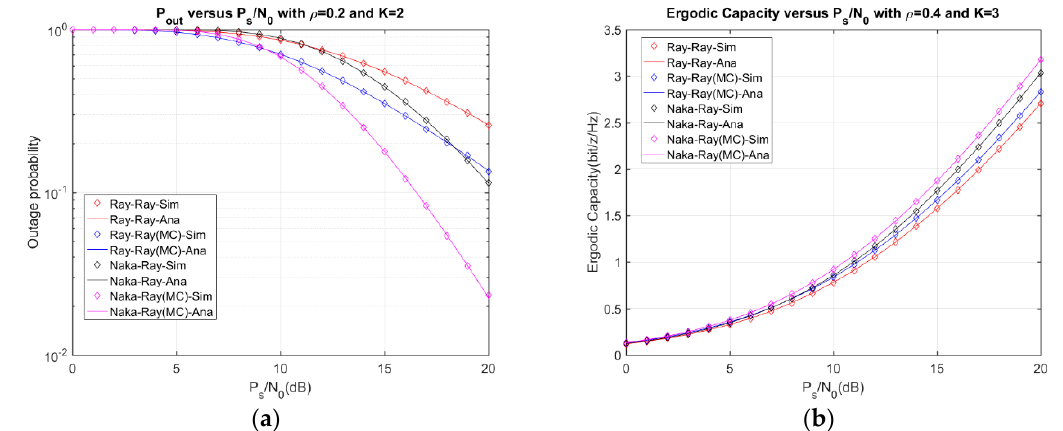
Figure 5. Comparison of the outage probability ( a ) and ergodic capacity ( b ) ersus P s /N 0 .